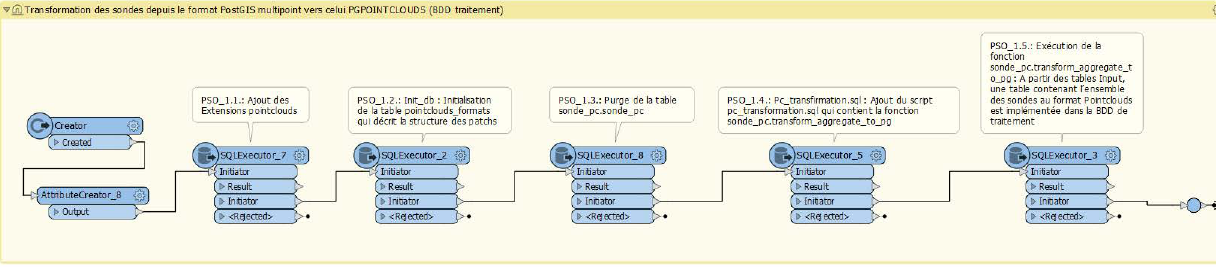
Figure 8. Example of FME interface performing the processing to generate the surface reference.